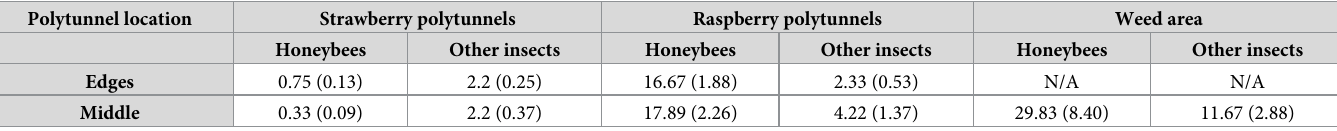
Table 1. Average insect count per quadrat along the polytunnels and in the middle of the uncovered weed with the mean and standard error of the mean (SEM) shown in brackets. Polytunnel